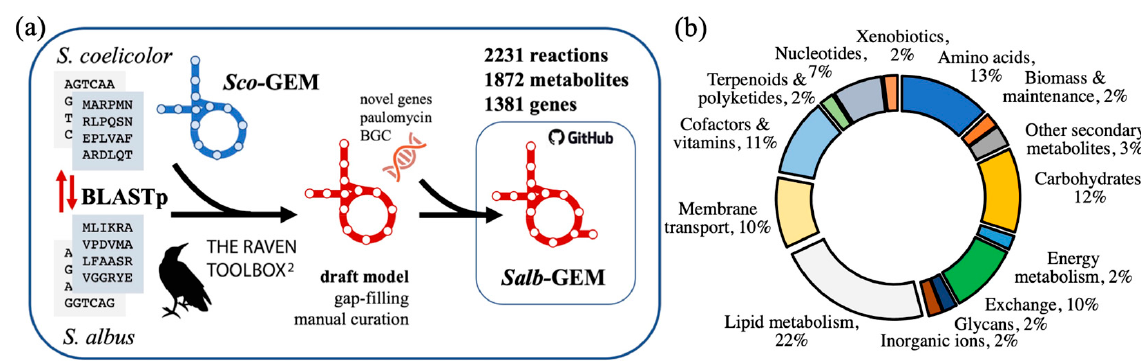
Figure 1. ( a ) overview of reconstruction and developmental pipeline of Salb -GEM. An initial draft model is developed using the RAVEN Toolbox with a protein FASTA of the Streptomyces albus J1074 genome and Sco -GEM as a template model. After manual curation and gap-filling of the metabolic network, additional genes and reactions specific to S. albus were incorporated externally from KEGG based on trained hidden Markov models (HMMs). Salb -GEM is distributed openly on GitHub, a version control and software development platform. ( b ) distribution of reactions sorted by metabolic subsystems.